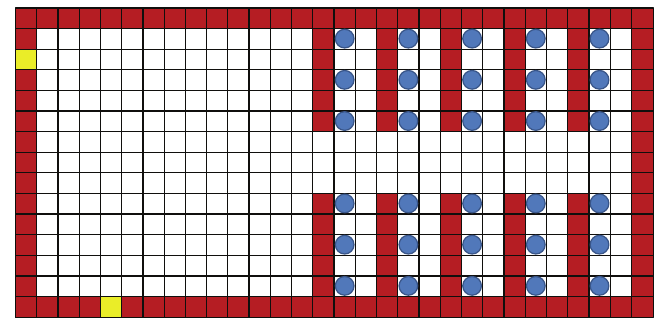
Figure 8: A room with 30 occupants and two single-door exits.